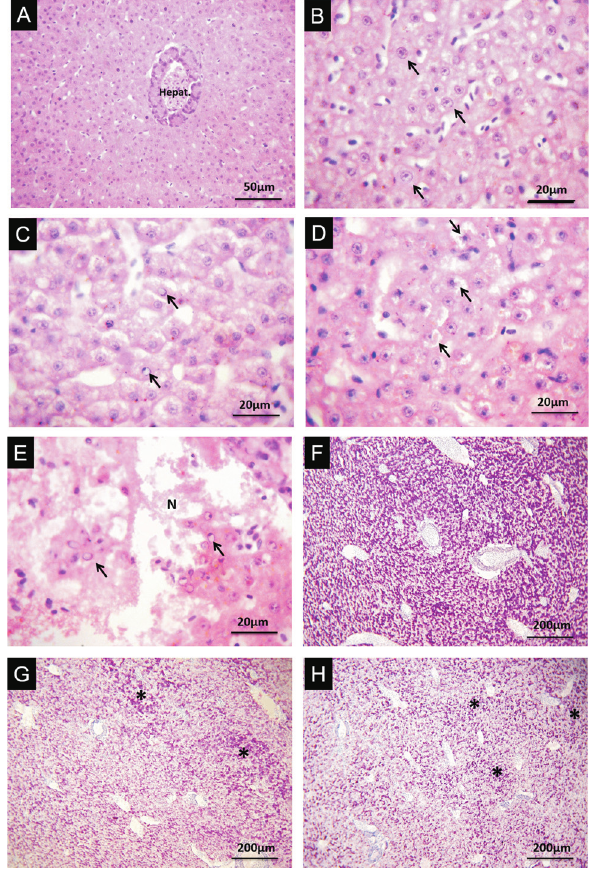
Figure 4 - Liver histopathology of C. macropomum in the three experi- mental groups: Group Without Injection (GWI); Group with corn oil in- jection (Sham); and Group with naphthalene injection (Naph) after 96 h normoxia exposure followed by 6 h of hypoxia. (A) normal C. macropomum liver standing out the hepatopancreas. (B, C) after Naph in- jection in normoxia. Arrows indicate nuclei hypertrophy (B) and nuclei vacuolization (C). (D, E) after Naph injection and subsequent hypoxia ex- posure. Arrows indicate hepatocytes with nuclei degeneration (D) and nu- clei vacuolization (E); N shows focal necrosis. Hematoxylin and eosin stain. (F) C. macropomum liver of the Sham group in normoxia demon- strating a strong positive reaction to PAS. (G, H) C. macropomum liver af- ter hypoxia exposure: GWI (G) and Naph groups (H) demonstrating a weak reaction to PAS. Asterisks indicate areas with higher glycogen con- centration. PAS corresponds to Periodic Acid Schiff Stain